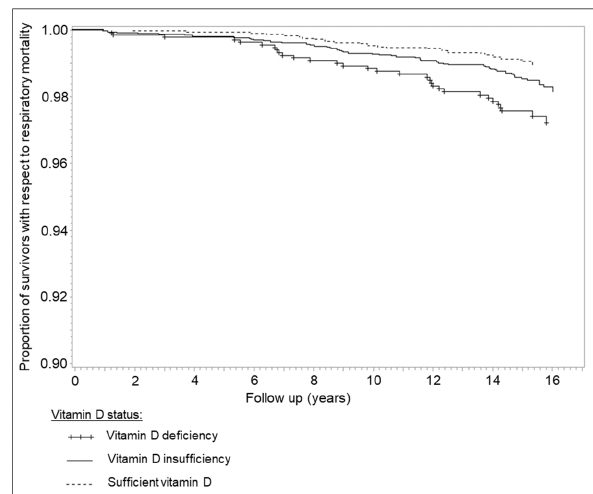
Figure 2. Kaplan-Meier curves for deaths from respiratory disease according to vitamin D status (unadjusted).